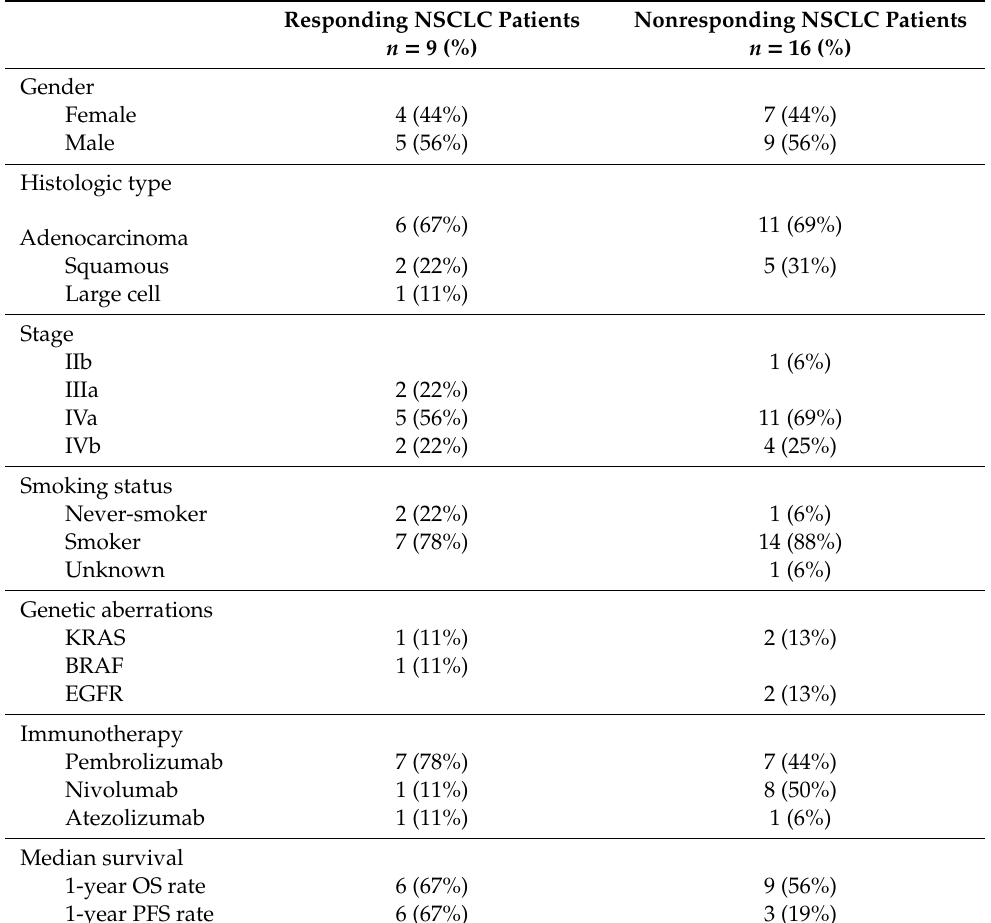
Overview of clinico-pathological characteristics of NSCLC patients who received immunotherapy